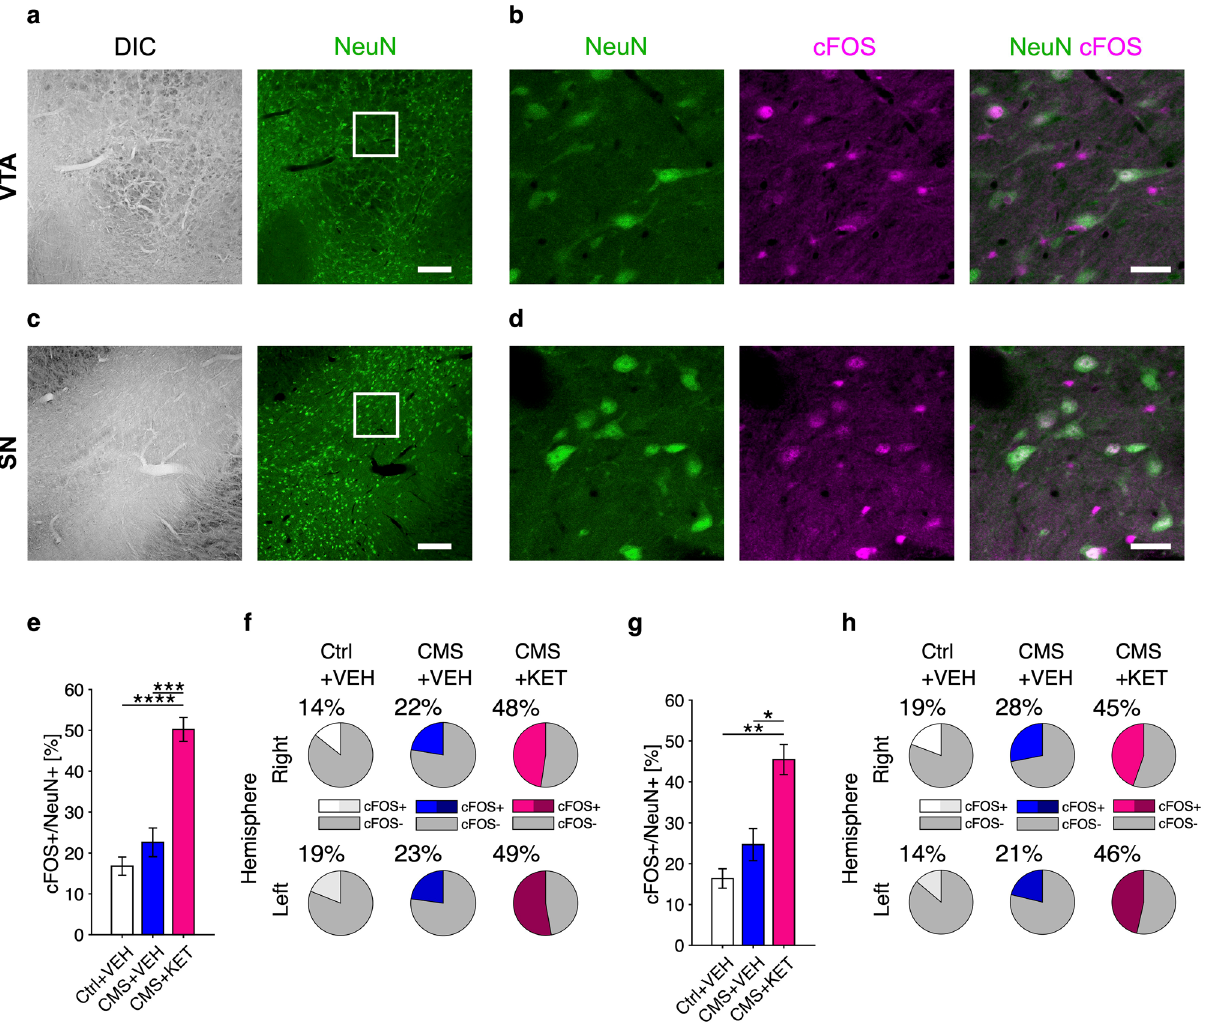
Figure 5. Effects of CMS and ketamine treatment on neuronal activity in the VTA and SN. ( a – d ) Exemplary low ( a , c ) and high ( b , d ) magnification images of VTA ( a , b ) and SN ( c , d ) stained for NeuN (green) and cFOS (magenta), together with DIC channel (gray) and merge; scale bars: 200 µm ( a , c ), 30 µm ( b , d ). ( e ) CMS did not significantly affect the relative number of cFOS+/NeuN+ cells in the VTA compared to controls, while ketamine (KET) treatment (10 mg/kg) after CMS produced strong enhancement of VTA activity (n = 88 field-of-views, FOVs, from 2 to 3 rats per group; likelihood ratio test on GLMM model, p = 0.002; all contrasts with B–H correction: CMS+VEH vs. Ctrl+VEH, p = 0.229; CMS+KET vs. Ctrl+VEH, p < 10 −4 ; CMS+KET vs. CMS+VEH, p = 0.0002). ( f ) The relative number (grand average) of cFOS+/NeuN+ cells in the VTA appears as homogeneous between the two hemispheres. ( g ) Similarly to the VTA case, CMS did not significantly increase the relative number of cFOS+/NeuN+ cells in the SN compared to controls, while KET treatment (10 mg/kg) after CMS significantly promotes cFOS expression in the SN (n = 82 FOVs from 2 to 4 rats per group; likelihood ratio test on GLMM model, p = 0.0096; all contrasts with B–H correction: CMS+VEH vs. Ctrl+VEH, p = 0.432; CMS+KET vs. Ctrl+VEH, p = 0.002; CMS+KET vs. CMS+VEH, p = 0.012). ( h ) The relative number (grand average) of cFOS+/NeuN+ cells in the SN appears as homogeneous between the two